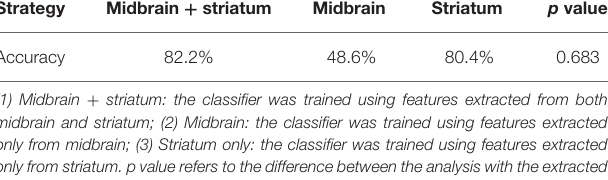
TABLE 7 | Accuracy of different combinations of regions of interest.